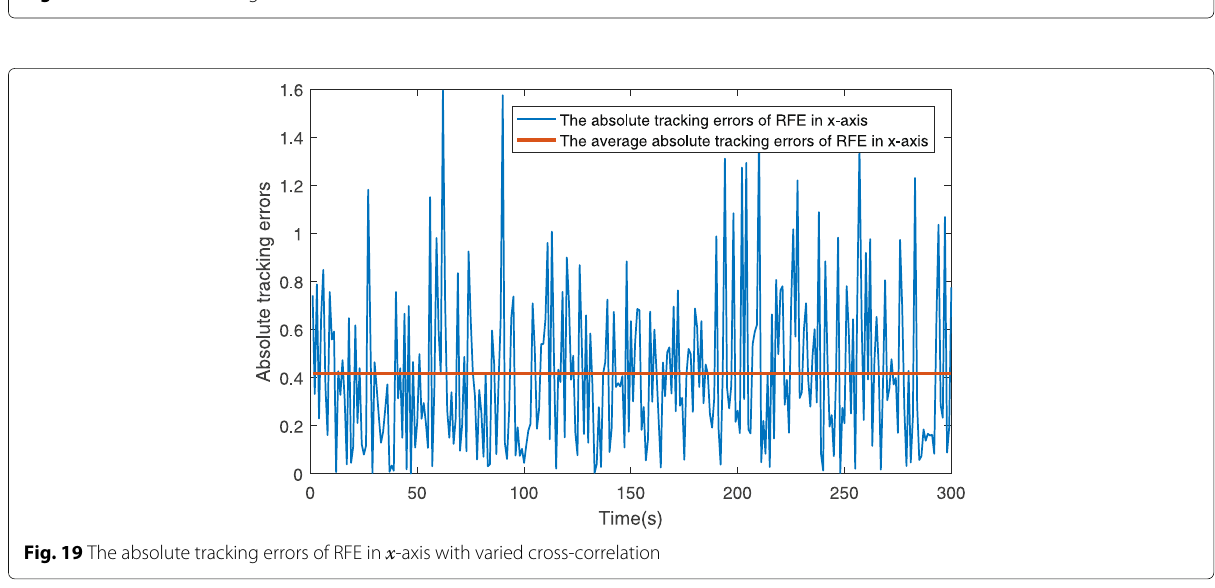
Fig. 18 The absolute tracking errors of CI method in x -axis with varied cross-correlation